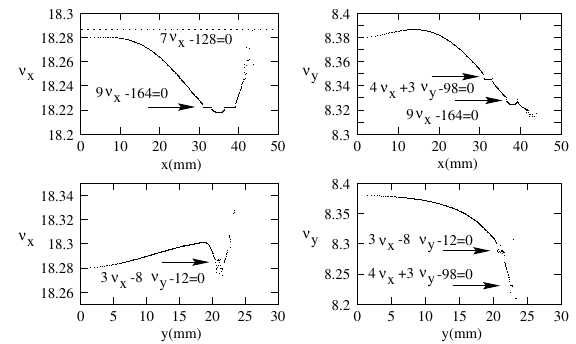
FIG. 4. SOLEIL first optics tune shifts with amplitude. For each case the fixed coordinate x or y is set to 1 (cid:1) m .